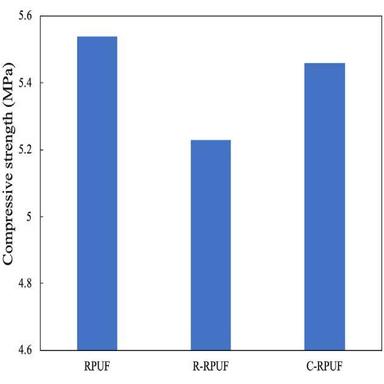
The compressive strength of RPUF, R-RPUF and C-RPUF.